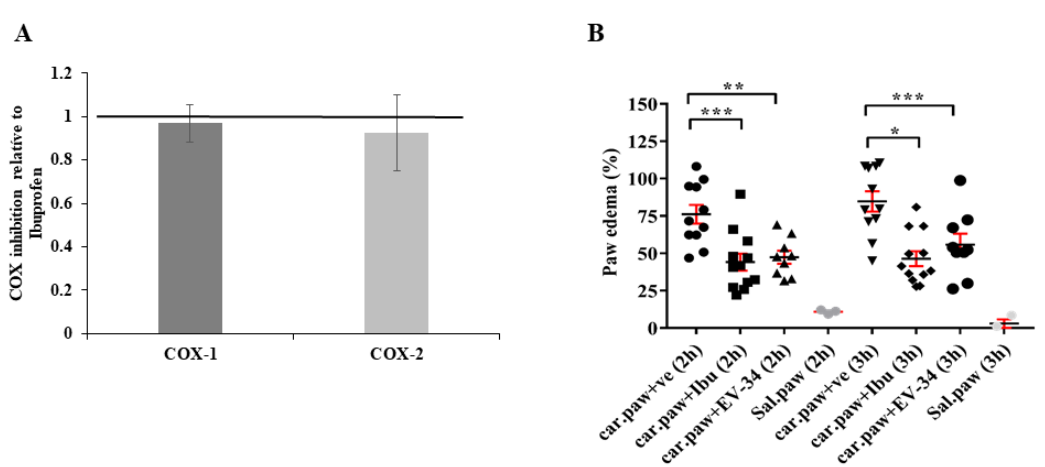
Figure 6. Anti-inflammatory effects of EV-34. ( A ) COX-1 and COX- inhibition relative to ibuprofen. ( B ) Effects of ibuprofen and EV-34 on carrageenan-induced edema in rat paws. The degree of edema in the rat paw tissue was calculated as the ratio of the change in paw volume between the basal volume (0 h) and at different time intervals of 2, 3 h after carrageenan injection. After intra-paw injection of carrageenan rats were treated intraperitoneally either with ibuprofen-sodium (100 mg/kg), or EV-34, or saline as vehicle control. Data are expressed as the mean ± SEM ( n = 9–12); * p < 0.05, ** p < 0.01, *** p < 0.001 versus the vehicle treated carrageenan injected group. A total of 3 rats were given intra-paw injection of saline as volume load control.